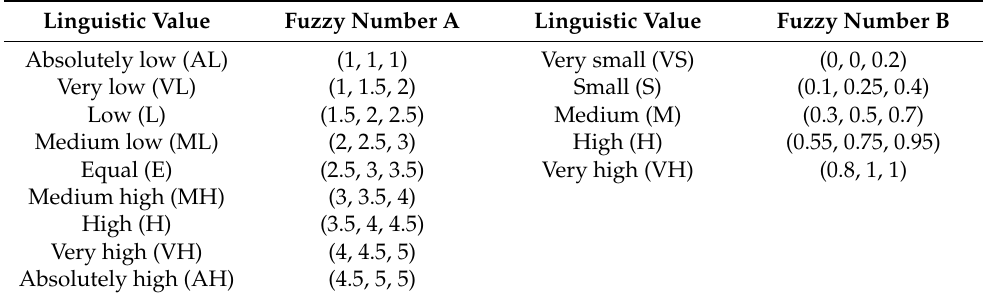
Table 2. Linguistic values for evaluating the weight of the criteria and the alternative. Linguistic Value Fuzzy Number A Linguistic Value Fuzzy Number B